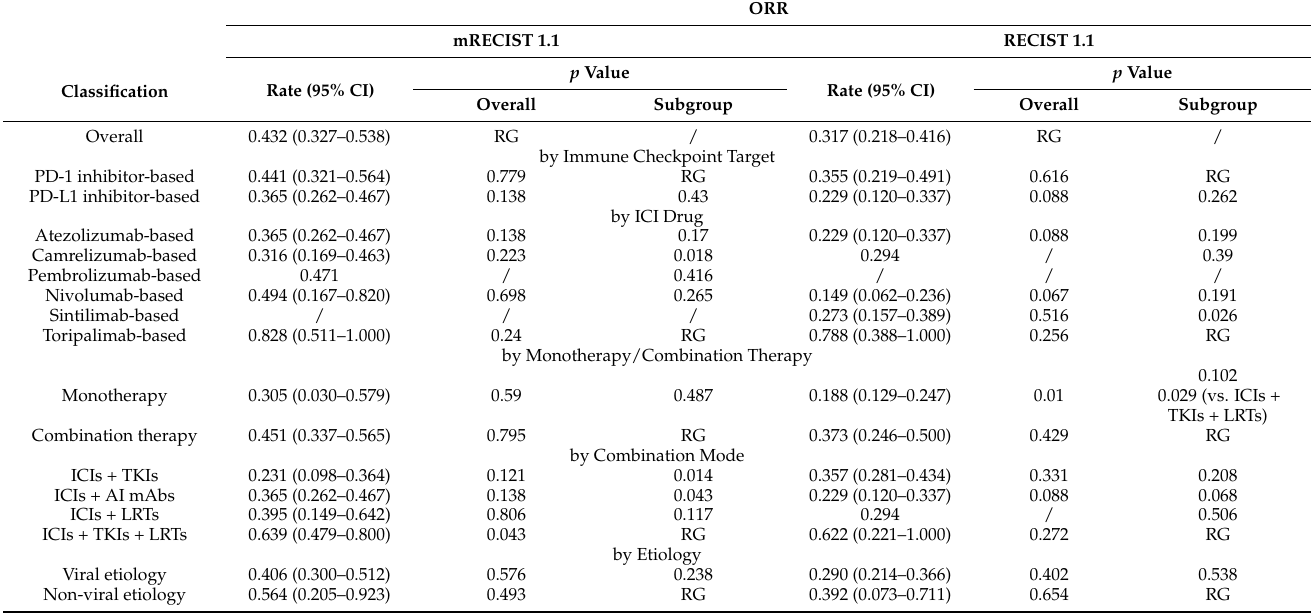
Figure 7. Subgroup analysis of DCR judged by RECIST 1.1. Table 3. Statistical analysis of response rates in advanced HCC patients receiving first-line ICIs-based